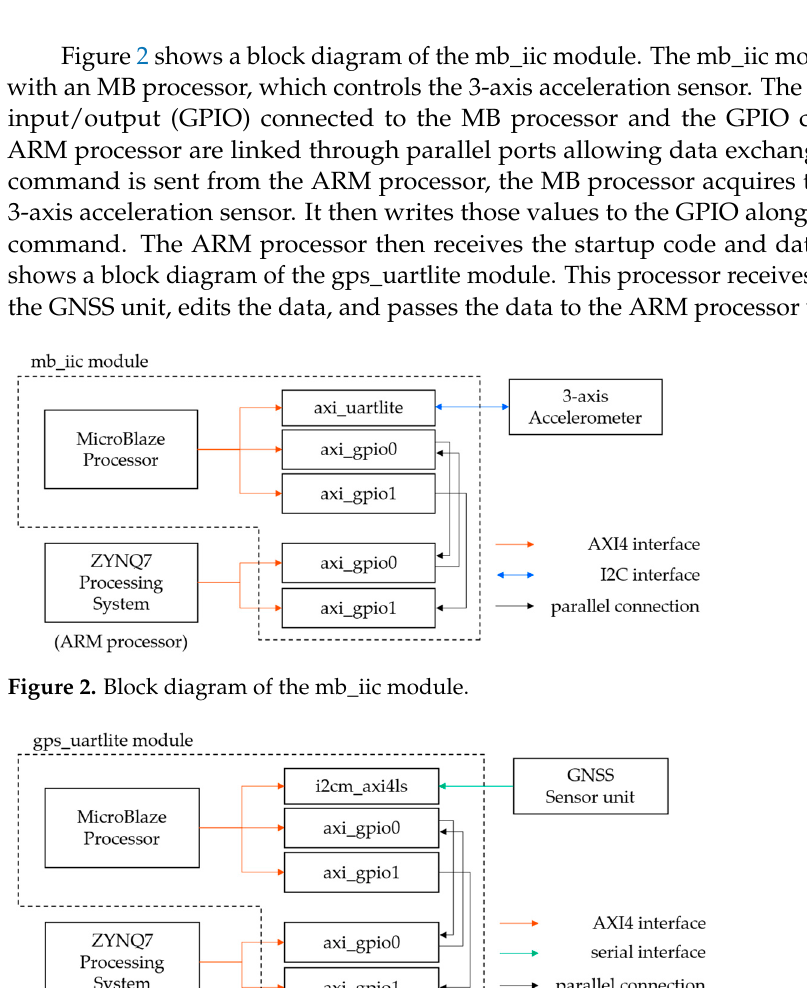
Figure 1. Block diagram of the Zynq chip adopted in the vibration measurement system; this sensor has two FPGA-based MB processors to obtain vibration and position data. MB processors are con- trolled by the ARM processor on the ZYNQ7 Processing System.